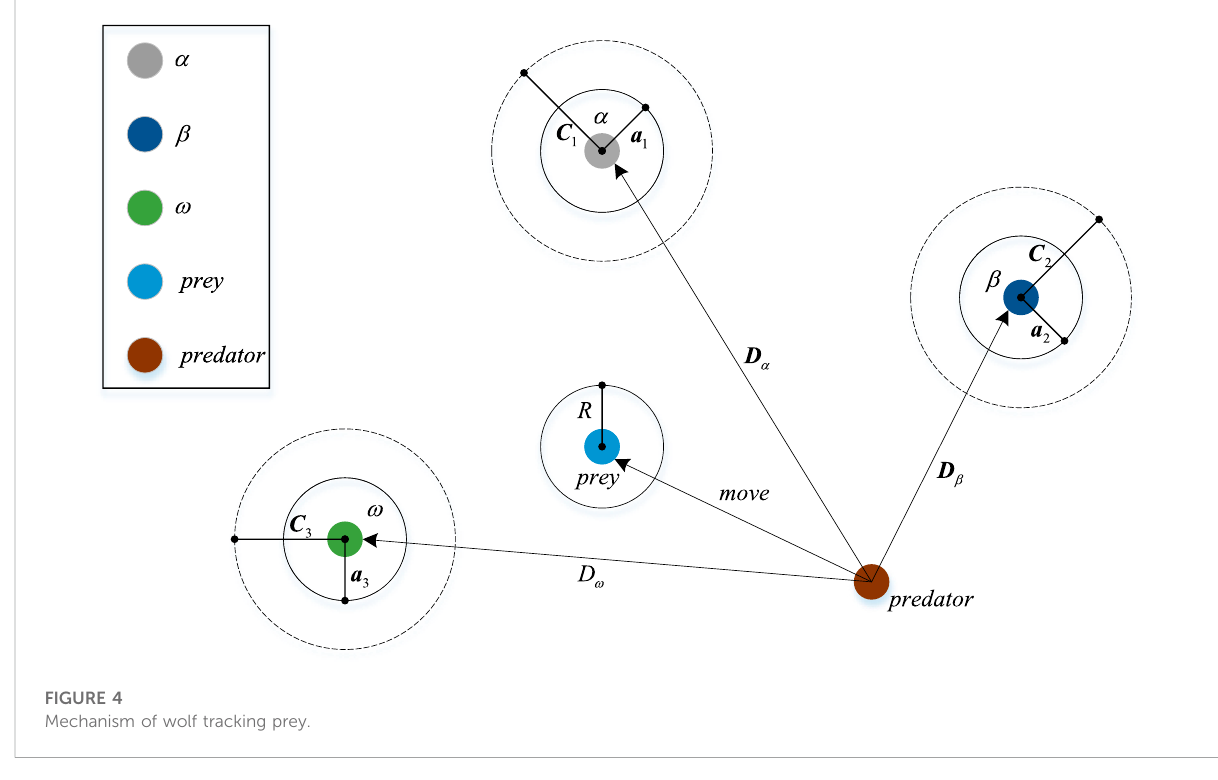
FIGURE 4 Mechanism of wolf tracking prey.